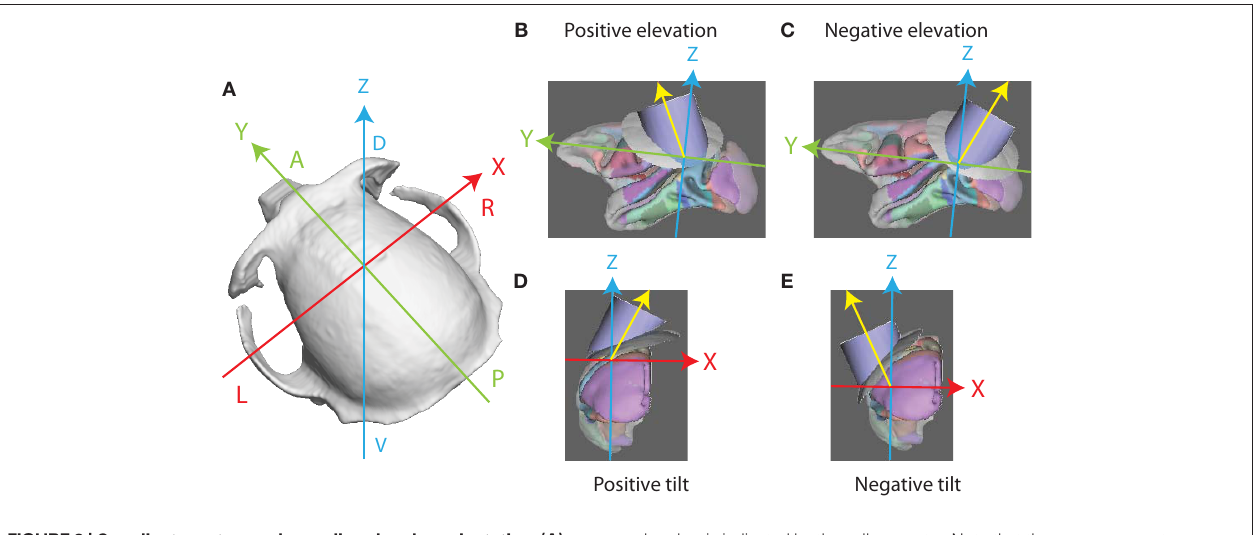
Figure 2 | Coordinate system and recording chamber orientation. (A) Stereotactic coordinate system: the X axis extends from left to right, the Y axis from posterior to anterior, and the Z axis from ventral to dorsal. The axes intersect at the origin of the coordinate system. (B) Recording chamber with a positive elevation angle. The orientation of the central axis of the recording